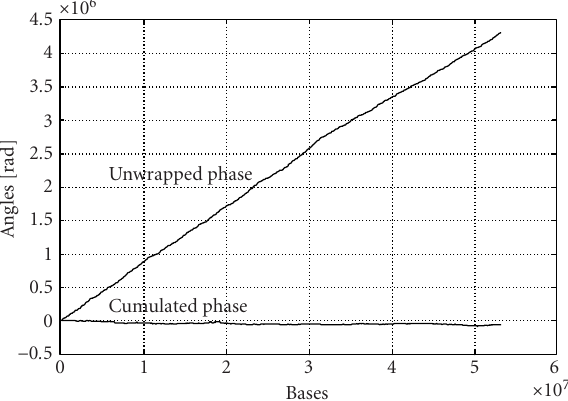
Figure 6: Cumulated and unwrapped phases along the complete